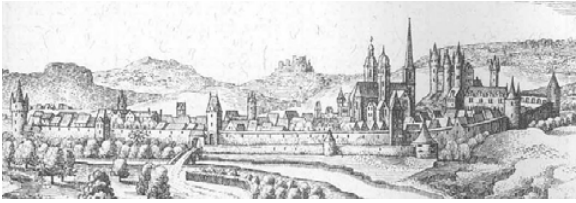
Figure 1: Herborn De Merian Hassiae by Matthäus